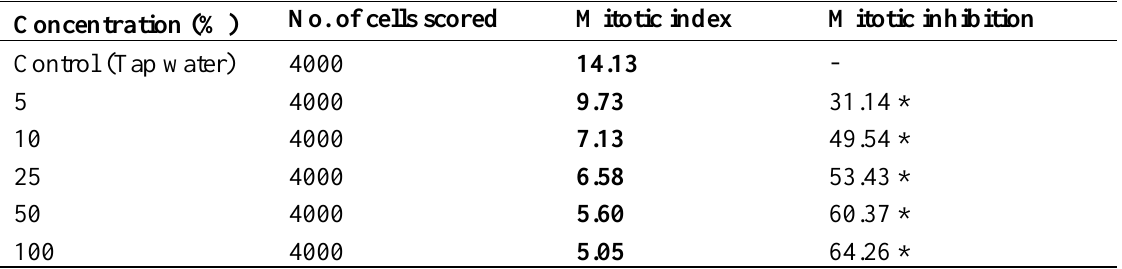
Table 4. Mitotic inhibition induced by different concentration of e-waste leachate sample on the root tip of A.